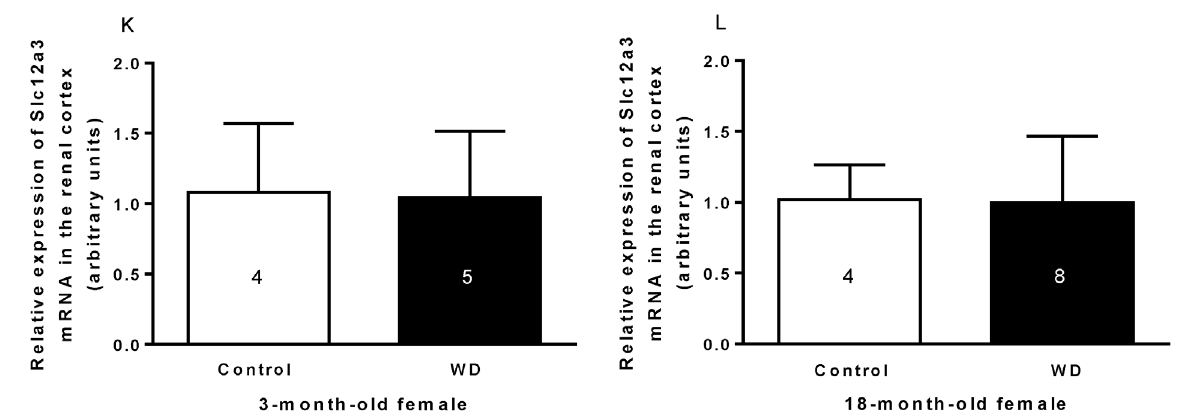
Figure 1. Relative Slc12a3 mRNA expression in the renal cortex of 3- and 18-month-old control and water-deprived (WD) male and female rats. Comparing by age in the control male ( A ) and female rats ( B ) and the WD male ( C ) and WD female rats ( D ). Comparing by sex in the 3-month-old ( E ) and 18-month-old control rats ( F ) and 3-month-old ( G ) and 18-month-old WD rats ( H ). Comparing by hydric condition in the 3-month-old ( I ) and 18-month-old male rats ( J ) and 3-month-old ( K ) and 18-month-old female rats ( L ). Data are presented as means (SD), * p < 0.05 relative to the reference group. Student’s unpaired t-test. Number (n) of the sample is indicated inside the column.